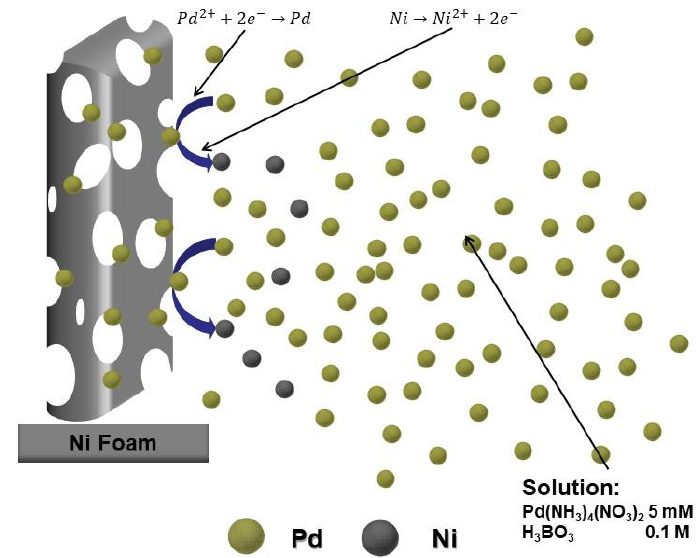
Figure 4. Scheme of galvanic displacement deposition of Pd on Ni-foam.